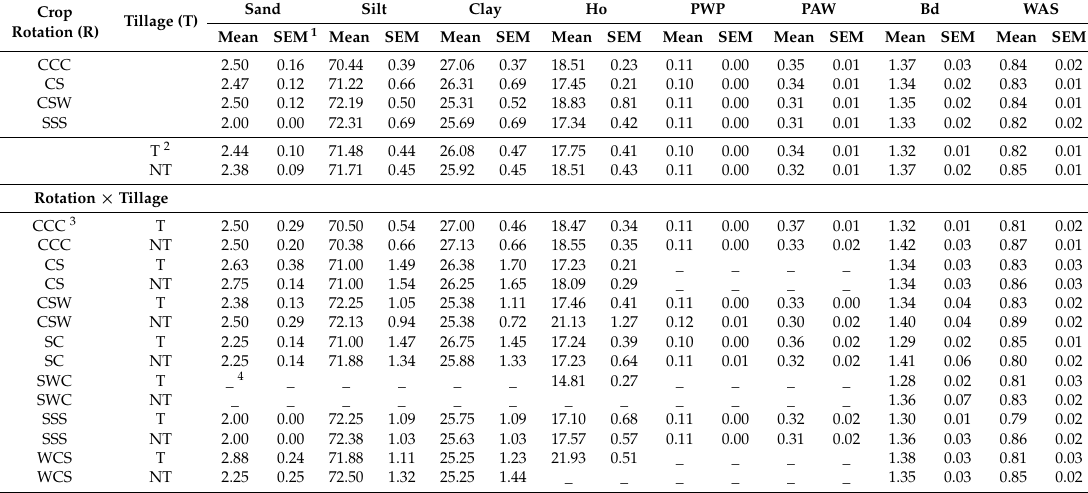
Table A5. Mean values of sand (%), silt (%), clay (%), average soil moisture (Ho, %), permanent wilting point (PWP, cm 3 cm − 3 ), plant available water (PAW, cm 3 cm − 3 ), bulk density (Bd, Mg m − 3 ), water aggregate stability (WAS, g g − 1 ), determined by crop rotation (R) and tillage (T) and for each R and T combination.